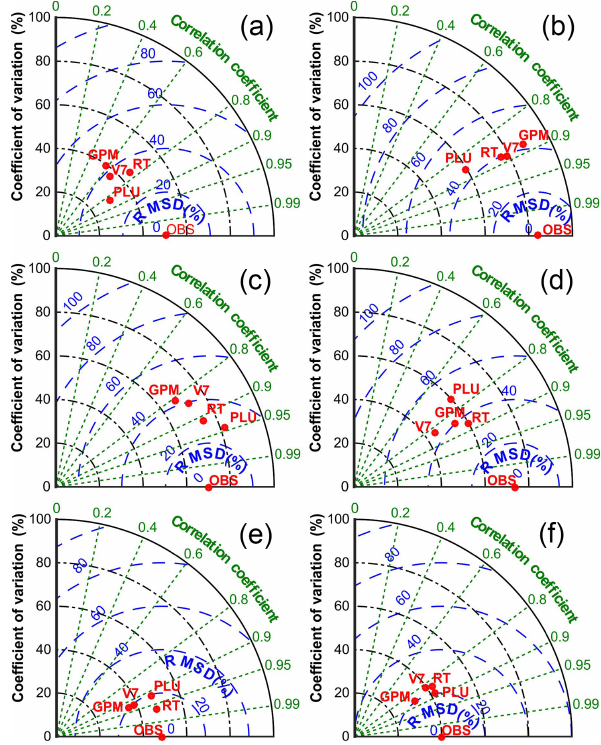
Figure 5. Taylor diagrams displaying a statistical comparison (co- efficient of variation (%), the root mean square difference (%) and correlation coefficient) between observed streamflows and mod- eled streamflows from four precipitation datasets (TMPA V7 (V7), TMPA RT (RT), GPM-IMERG (GPM), observed rainfall (PLU)) for six basins controlled at the following stations: (a) Chazuta (CHA), (b) KM105 (KM), (c) Mejorada (ME), (d) Lagarto (LA), (e) Pucallpa (PU) and (f) Requena